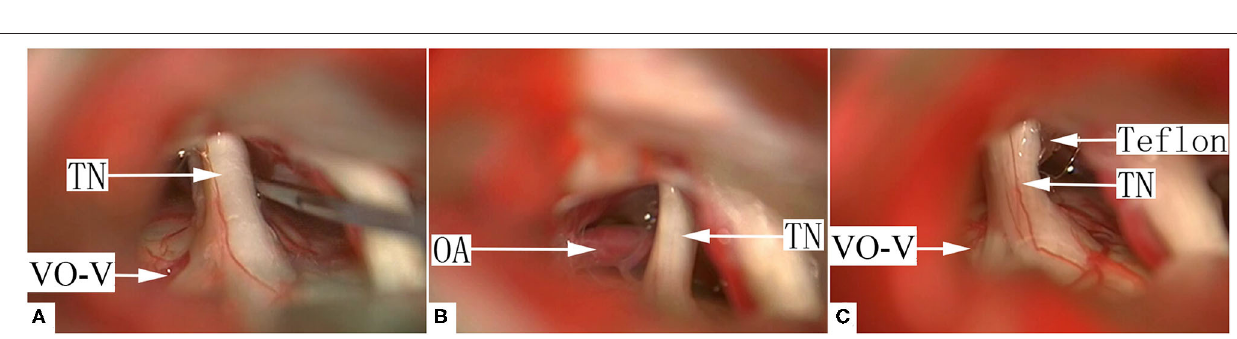
FIGURE 5 | A representative case of group II, type A VO-VREZ. (A) The whole length of the vein was covered by the nerve root. (B) There was a suspected offending artery behind the trigeminal nerve. (C) The suspected offending artery was decompressed by a shredded Teflon interposition. VO-VREZ was electrocoagulated